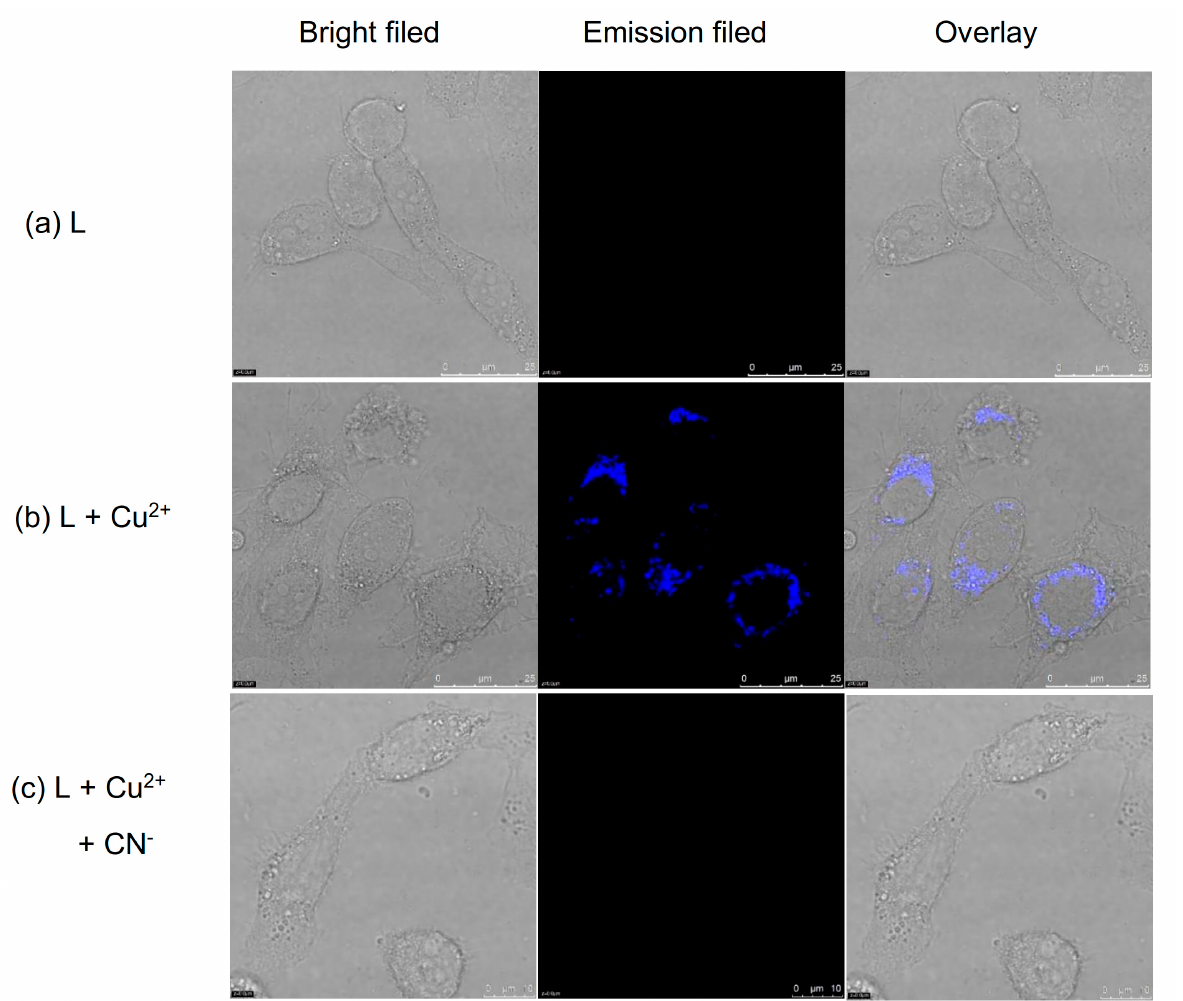
Figure 12. Confocal fluorescence images of HeLa cells ( left ) bright filed, ( center ) emission filed, ( right ) overlay. ( a ) HeLa cells incubated with 10 µ M of L for 10 min; ( b ) HeLa cells incubated 10 µ M of L in the presence of Cu 2+ (5 µ M); ( c ) after adding CN − (15 µ M). Excitation wavelength is at 410 nm.